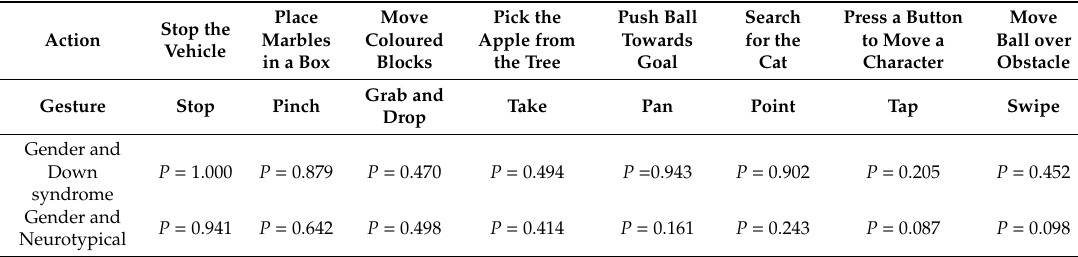
Table 6. Comparison of success rate by